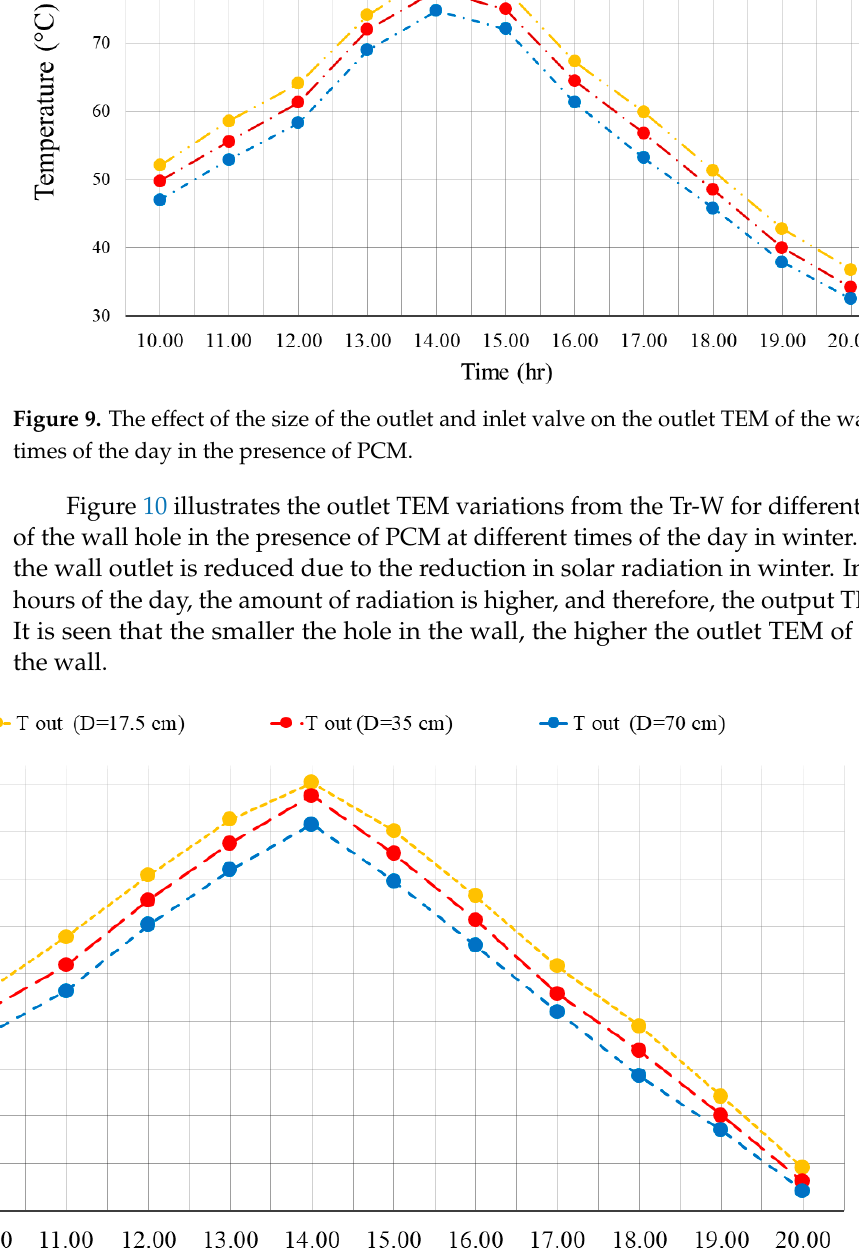
Figure 10. The outlet TEM variations from the Tr-W for different dimensions of the wall hole in the presence of PCM at different times of the day in winter.